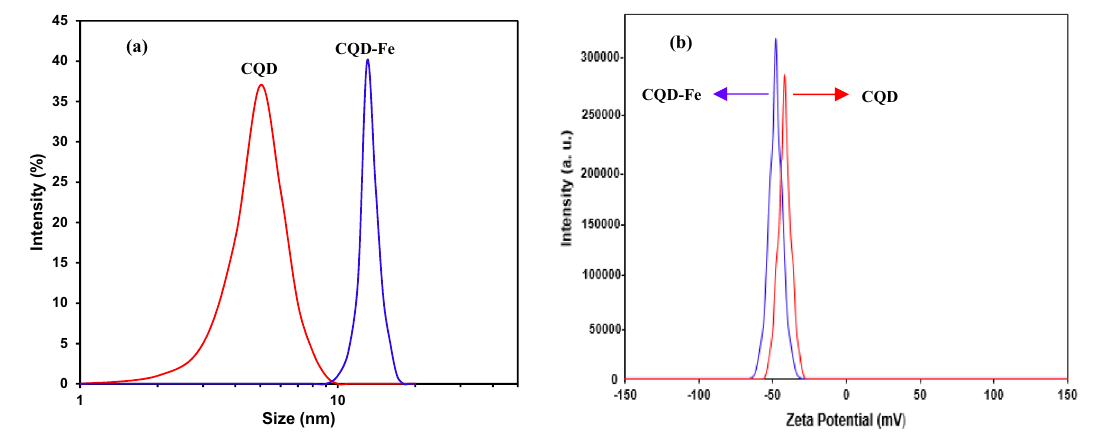
Figure 5. DLS analysis ( a ) and Zeta potential analysis ( b ) for the nanofluids containing 0.001wt% of the CQD and